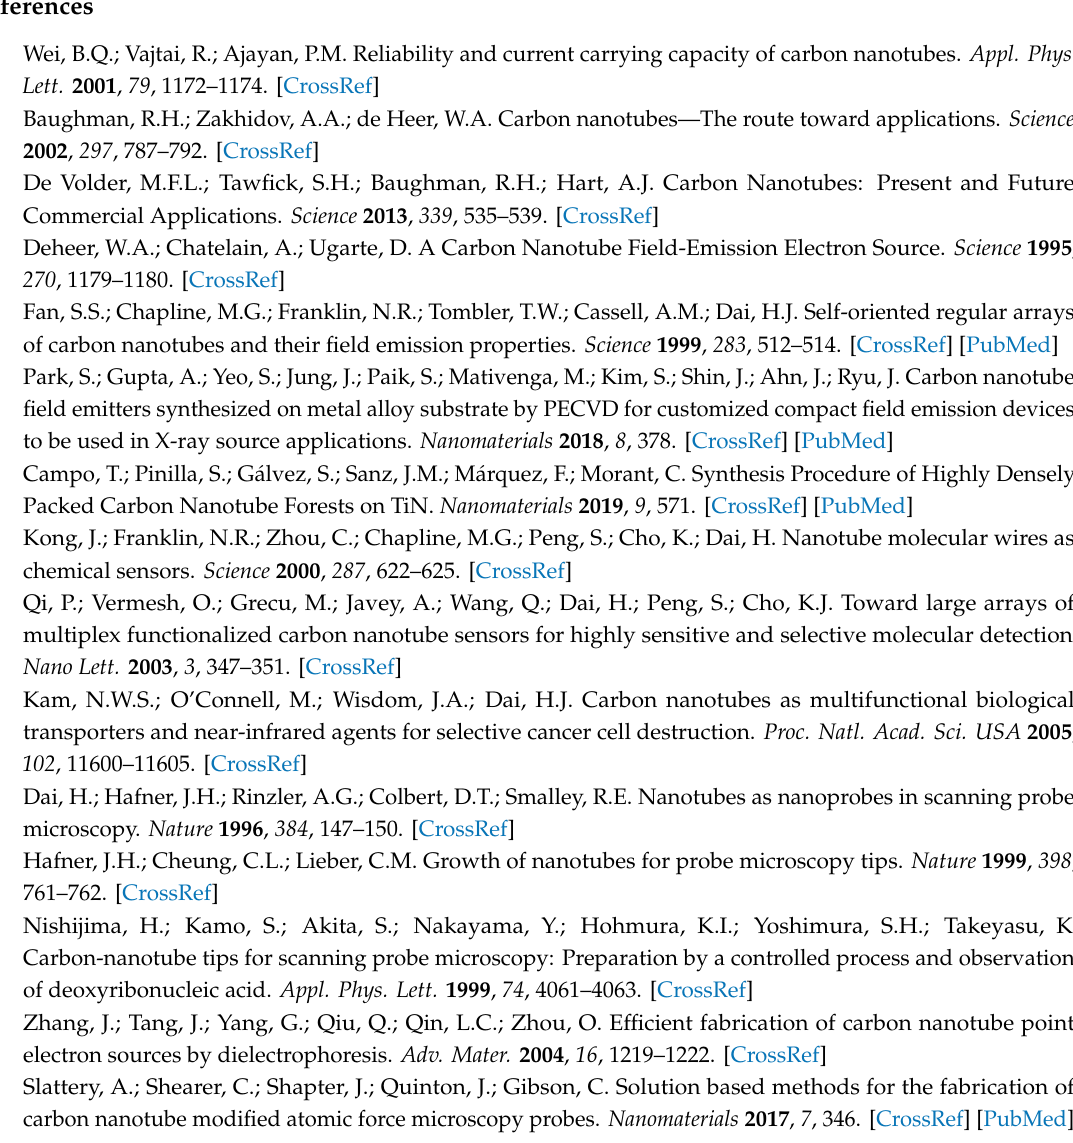
Figure S1: Oil-based markers to conduct preliminary synthesis testing, Figure S2: The specimen preparation process for CNT patterning using inkjet printers, Figure S3: Laser stripping to remove the ink from the surface of the